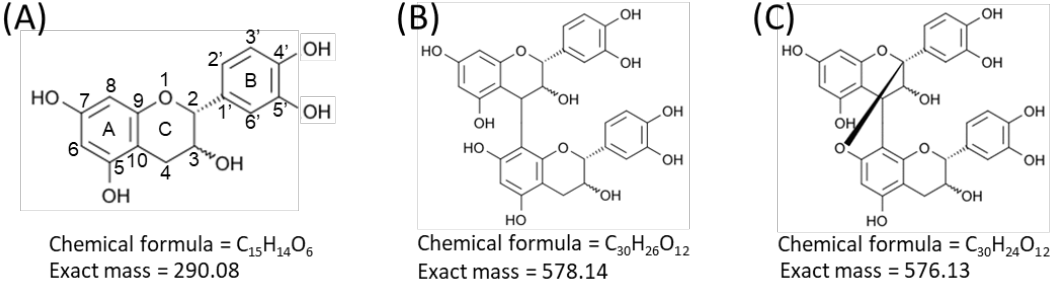
Figure 1. Structures of flavan-3-ol species. Structures of ( A ) catechin and epicatechin, flavan-3-ol units of procyanidin species, ( B ) B-type procyanidin dimers, and ( C ) A-type procyanidin dimers.